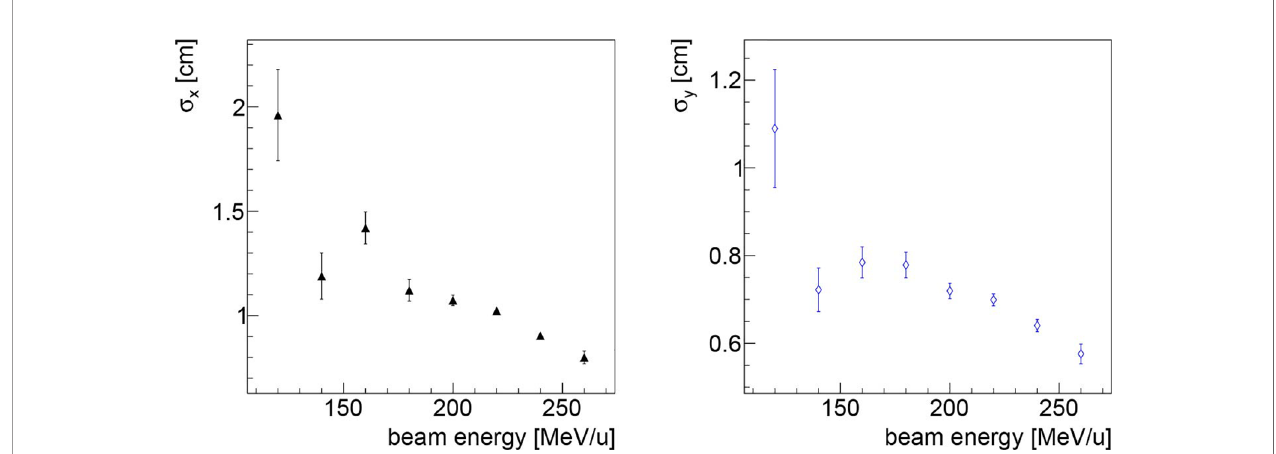
FIGURE 6 | Resolution on the beam transverse position as a function of the beam energy along the x (left) and y (right) directions, obtained analysing the data collected in fi rst fraction of PZC. As expected, the higher is the beam energy, the better is the resolution, as expected since there is a larger number of emitted fragments that are capable of escaping from the (cid:129) the number of particles detected per PB. The number of reconstructed tracks per PB is, on average, few tens, with a